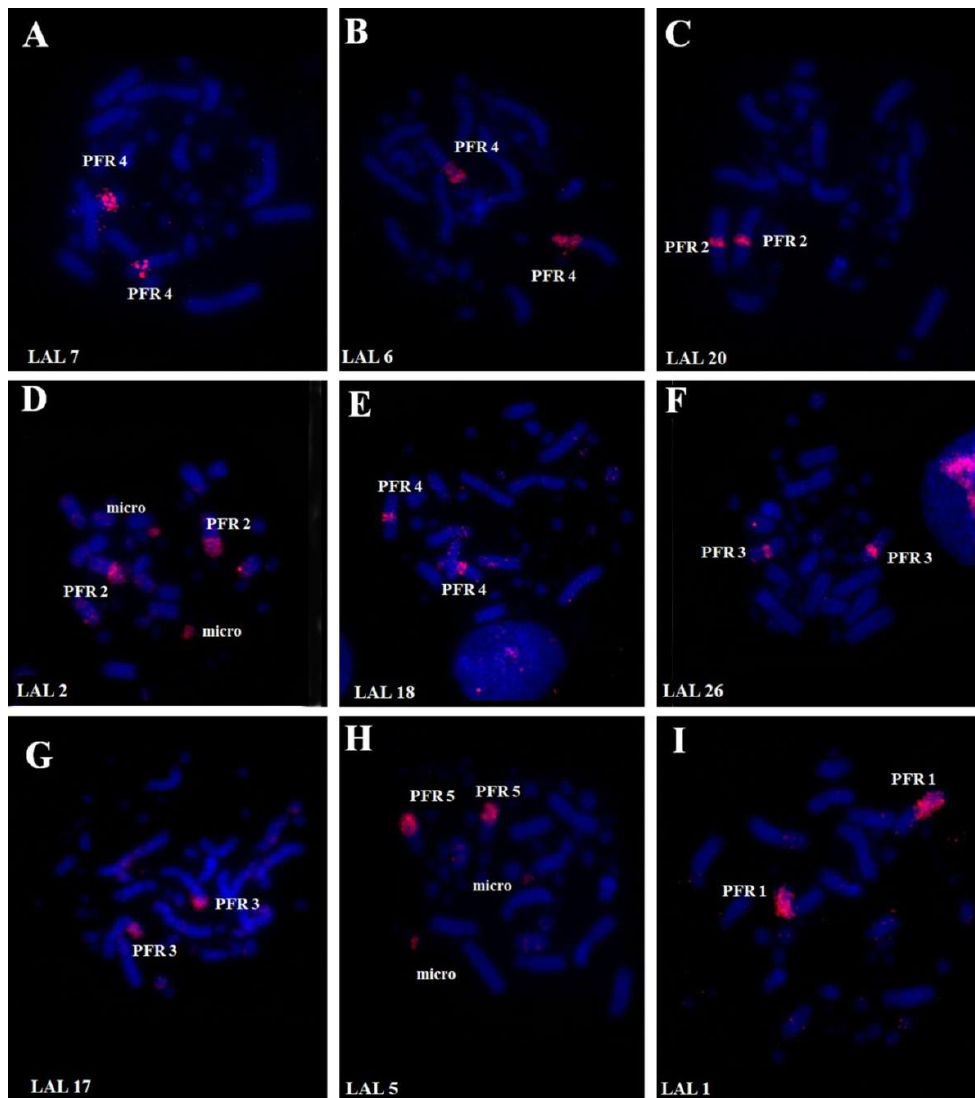
Figure 3. Fluorescent in situ hybridization using whole-chromosome probes of Leucopternis albicollis macrochromosomes in metaphases of P . frontalis . LAL: Leucopternis albicollis.